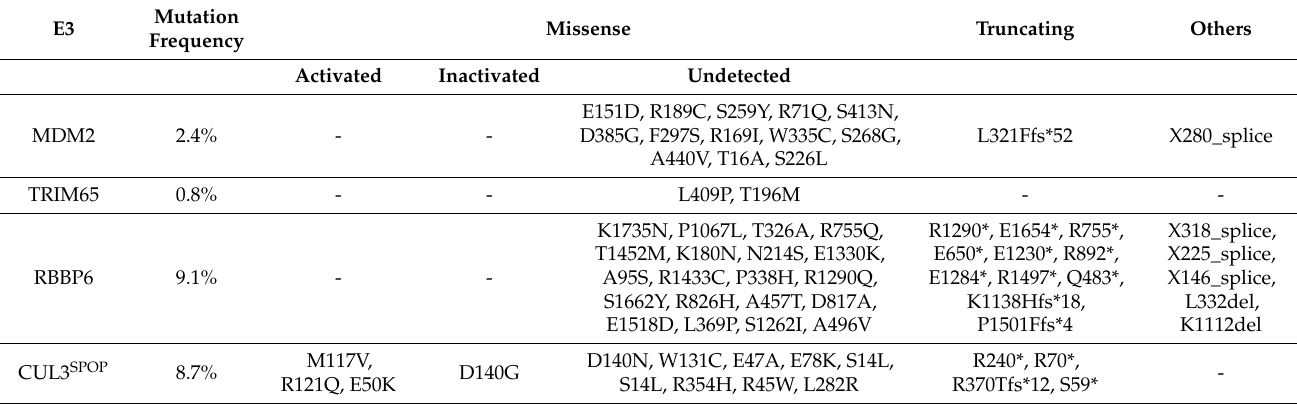
Table 2. Type and site of mutations in